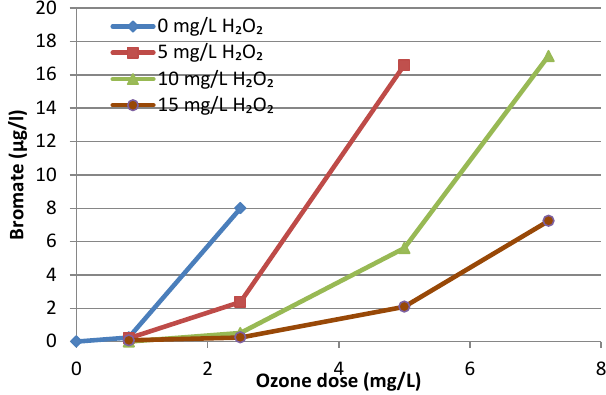
Figure 4. Bromate formation at different settings of the perox- one process (Br − 126µgL − 1 , HCO − 158mgL − 1 , DOC 3, 70mg CL − 1 , water temperature 9.7 ◦ 3